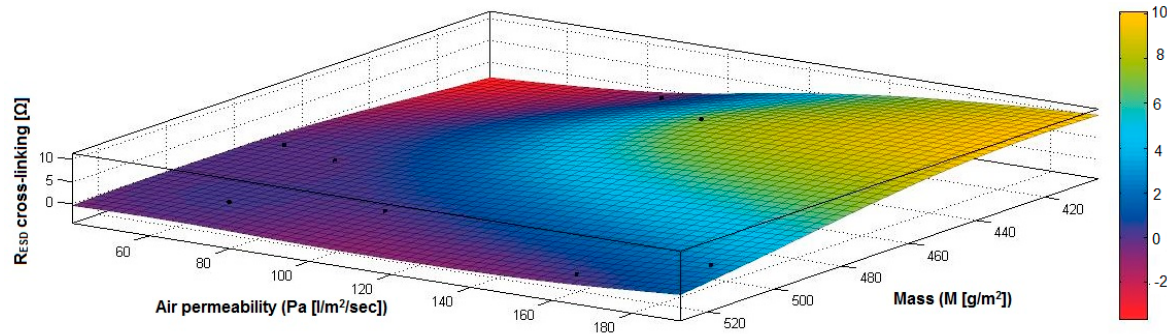
Figure 35. 3D representation R ESD after crosslinking = f(Pa, Pv) for samples preliminarily treated in RF plasma O 2 using RF 2 generator and power 100 W.